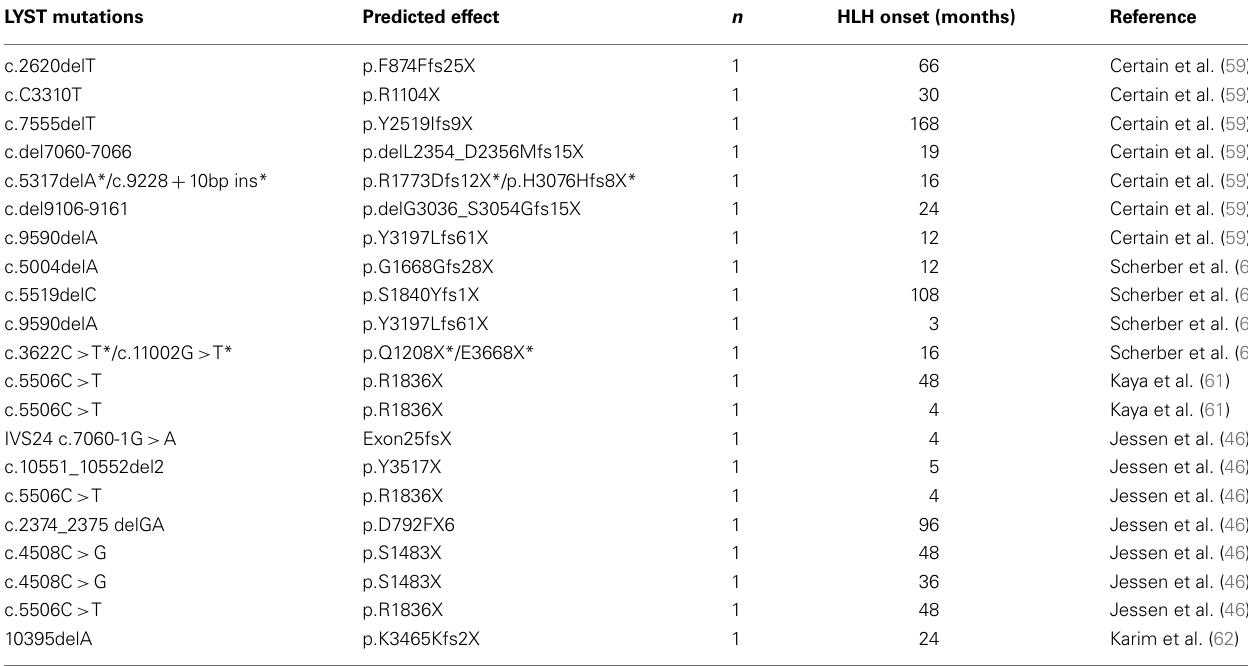
Table 3 | Genotype and age at HLH onset of previously published patients carrying severe bi-allelic mutations in CHS1/LYST